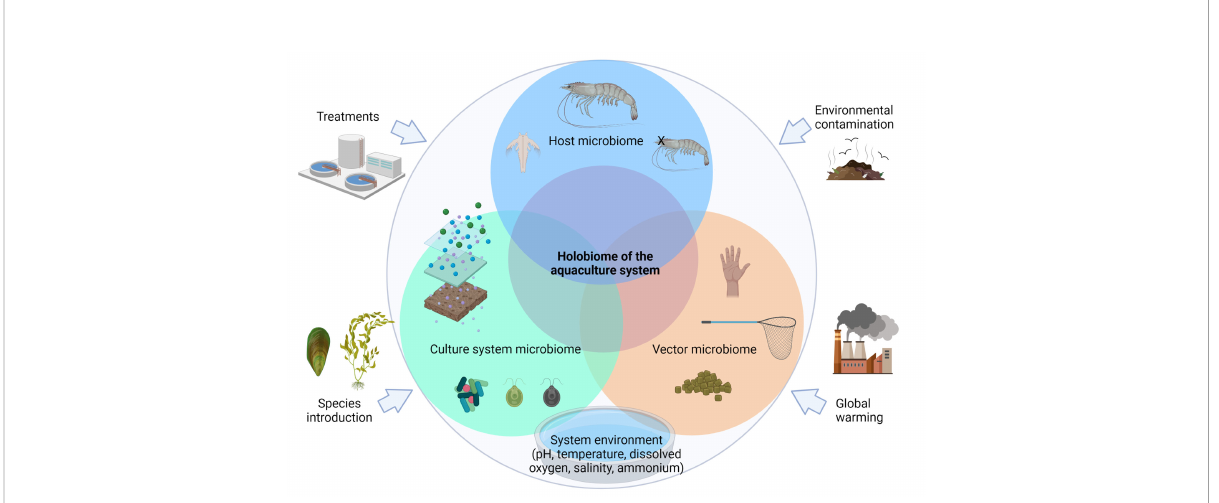
FIGURE 2 Components of the “ holobiome of the aquaculture system ” . “ Culture system microbiome ” involves the planktonic microbiome, sediment microbiome and bio fl oc microbiome; in “ Host microbiome ” can be included the skin, hepatopa ́ ncreas and midgut microbiome among others; “ Vectors microbiome ” involve those components that can actively introduce exotic microbiomes; “ Holobiome of the aquaculture system ” are intended to identify bene fi cial microorganisms, commensals, symbionts, pathogens and potential